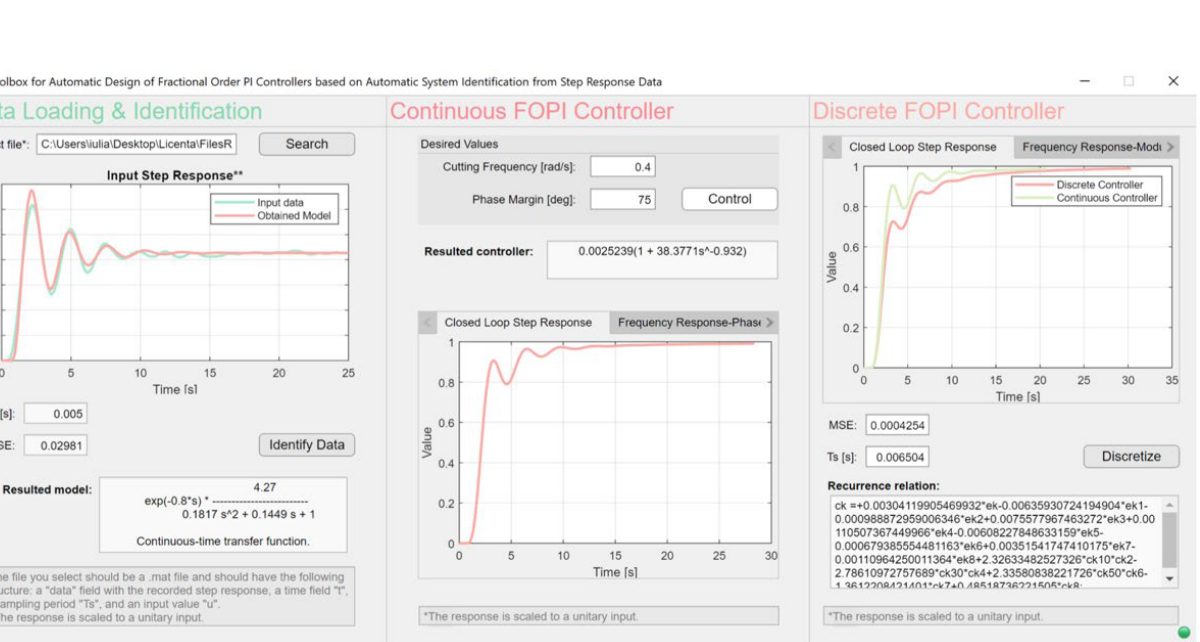
Figure 5. The case study: vertical take-off and landing platform.